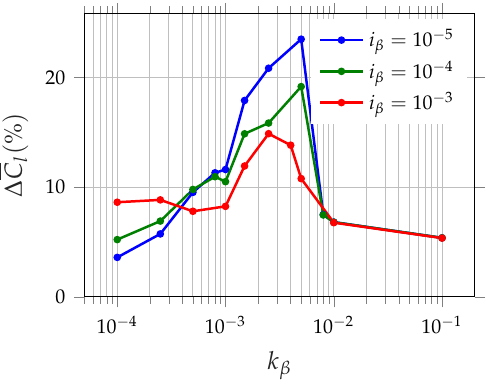
Figure 6. Performance plots showing percentage change in mean lift with respect to the baseline airfoil case for the various values of inertia ( i β ) and stiffness ( k β )